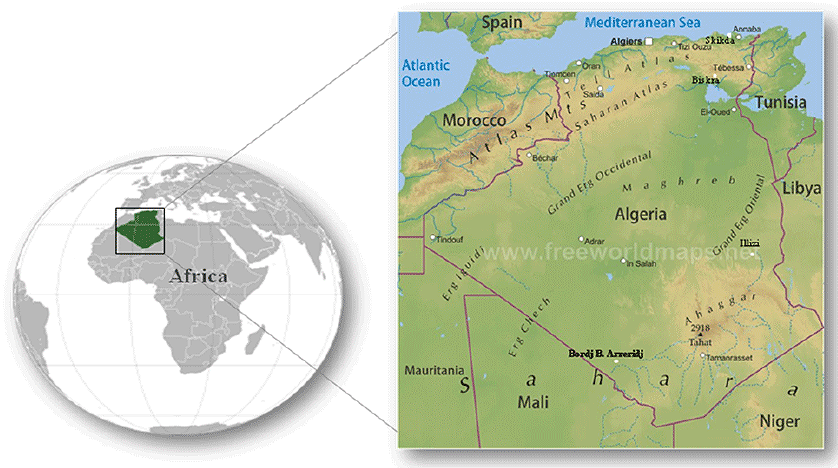
Figure 1. Geographical location of the study area